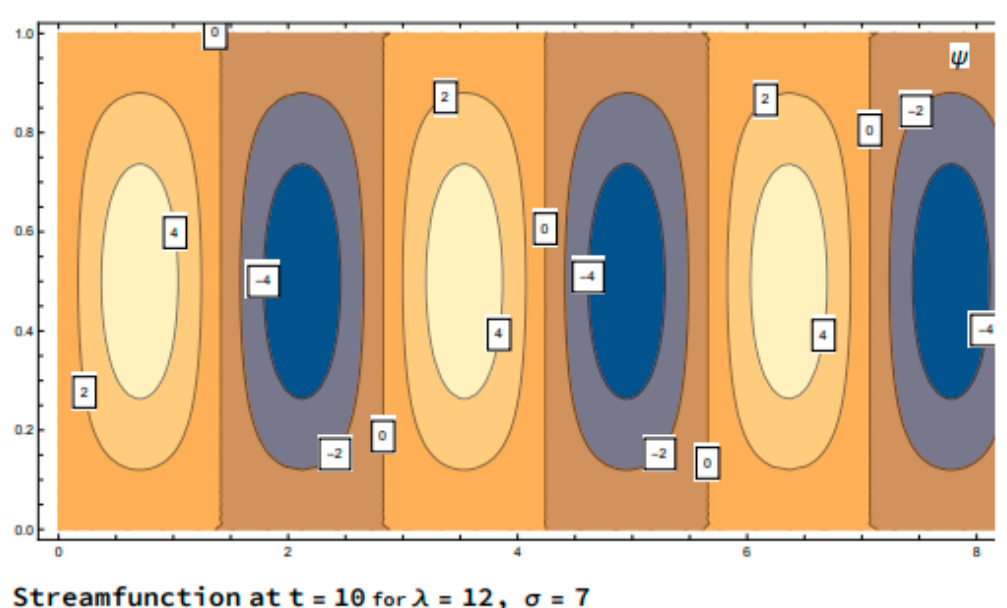
Figure 3. Display of convection pattern in the x − z plane at time = 10 for the nonchaotic regime with controls λ = 12, σ = 7.